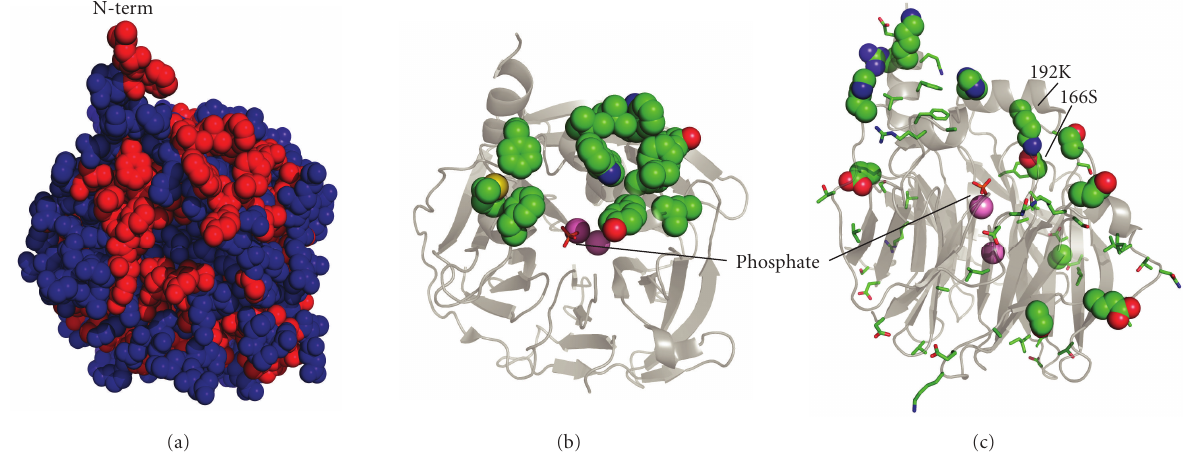
Figure 3: PON1 solubilizing mutations. (a) The surface of G2E6 is shown, with hydrophobic amino acids (VGMCILYFW) shown in red. Residues 1–15 are not resolved in the X-ray crystal structure, but the Δ N-huPON1 variant removed residues 4–17. (b) The positions modified in the Δ HDL-huPON1 variant are shown in spheres. These residues compose much of the hydrophobic surface patch near the N-terminus evident in (a). The Ca 2+ ions are shown as pink spheres, and a phosphate bound in the presumed active site is shown in orange sticks. (c) The 59 positions that di ff er between huPON1 and G2E6 are shown; the positions that were modified in g2e6p-huPON1 are spheres, and the other 43 positions are sticks. Position 166, which was modified because of its proximity of 192, is noted. Rendered from PDB ID: 1V04 with